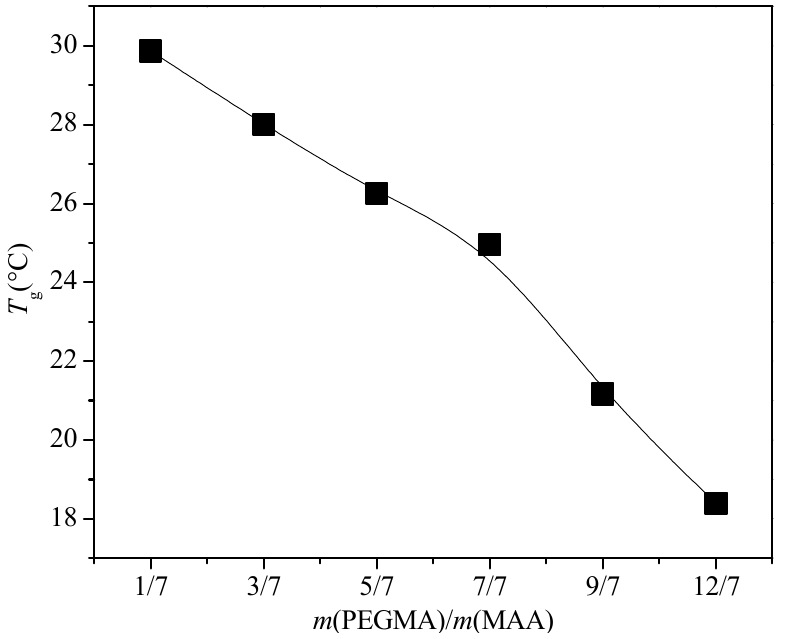
Figure 2. T g of the emulsion polymer with different mass ratios of PEGMA/MAA.